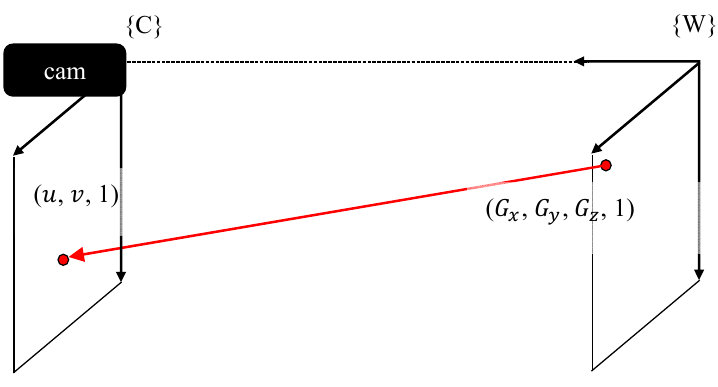
Figure 10. Mapping world coordinates to pixel coordinates.